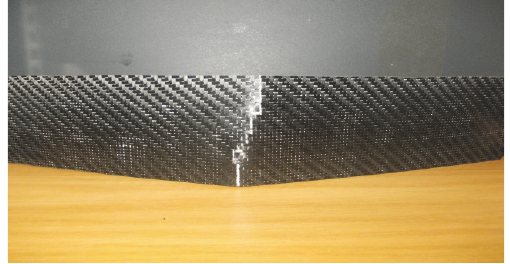
Figure 5: Sample failed after bending test.